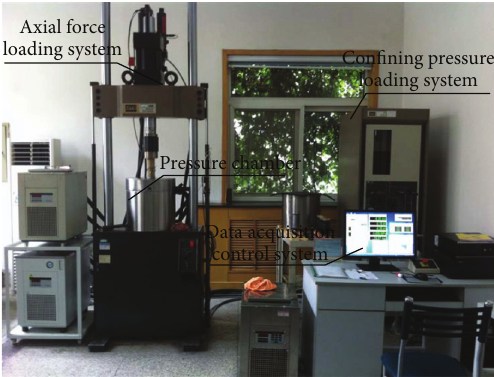
Figure 1: The repeated load triaxial